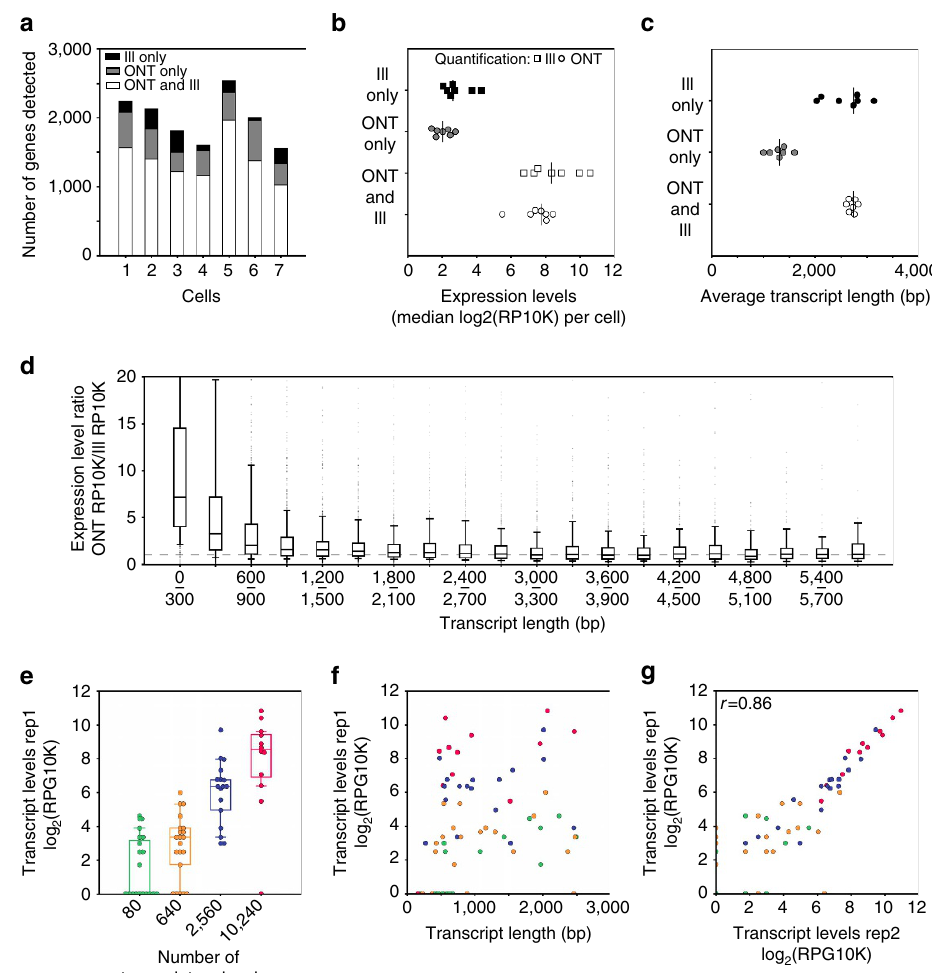
Figure 3 | Quantifying gene and transcript expression with ONT RNAseq data. ( a ) Stack barplots showing the number of genes detected in each cell corresponding to different sequencing technologies (Ill—Illumina, ONT—Oxford Nanopore). ( b ) Median expression levels of genes detected by both or individual technologies. Two expression levels (Ill and ONT) are given for genes detected in both technologies. ( c ) Gene length of genes detected by both or individual technologies. ( d ) Ratio of gene expression levels for genes detected by both technologies. Ratios are binned according to gene length and shown as boxplots with whiskers indicating 10th and 90th percentiles. ( e ) SIRV transcript levels of Replicate 1 (Rep1: 100fg SIRV pool E2) as measured with ONT RNAseq. Transcripts are binned by their starting molecule numbers. ( f ) SIRV transcript levels of Replicate 1 are plotted against transcript length with colours corresponding to groups in e . ( g ) Scatter plot showing correlation of SIRV transcript expression levels of Replicate 1 (Rep1: 100fg SIRVpool E2) and Replicate 2 (Rep2: 100fg SIRV pool E2), both measured by ONT RNAseq. r -value shown is Pearson r . Colours corresponding to groups in e